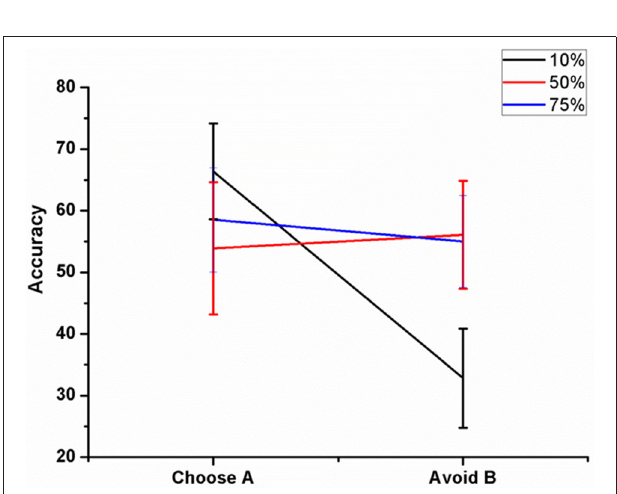
stimulation of STN for each of the 3